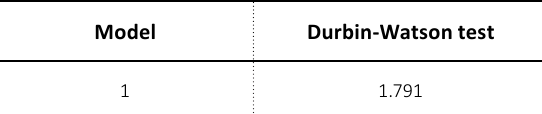
Table 4. Autocorrelation test results